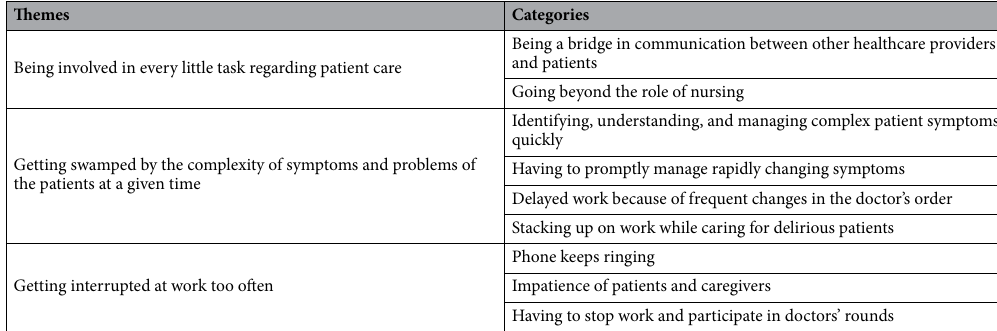
Table 5. Themes and categories of multitasking-related difficulties of